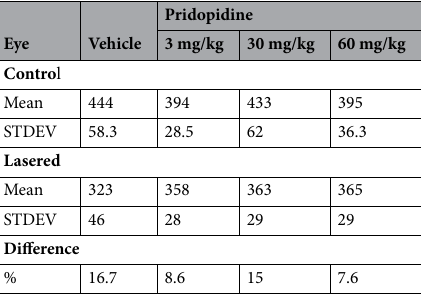
impaired MMP and increases RGC survival 57,58 .